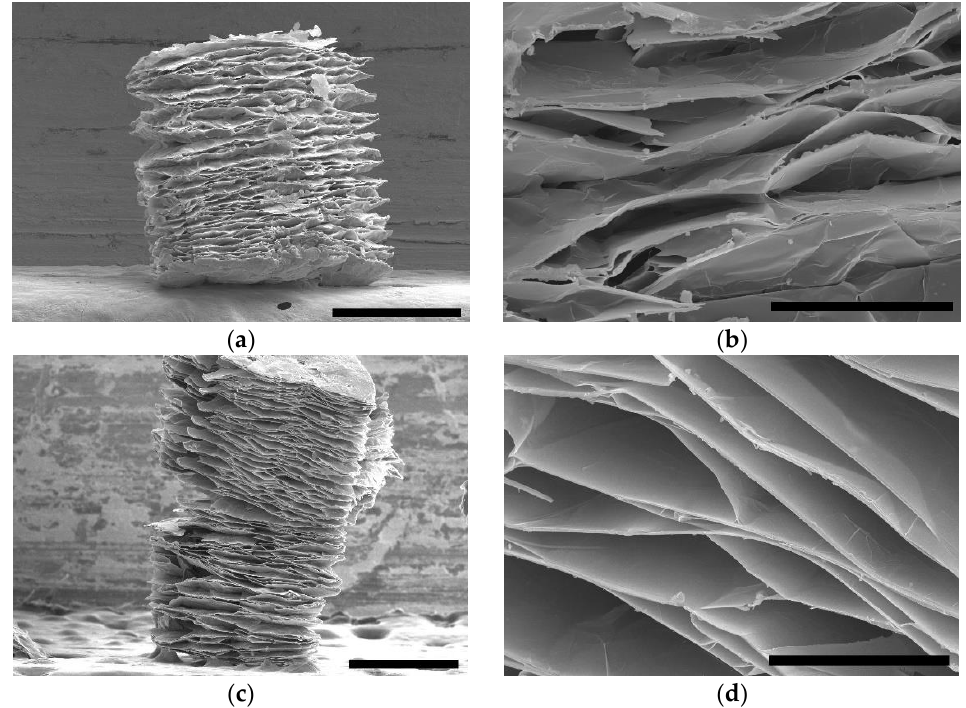
Figure 1. SEM images of ( a , b ) eVMT and ( c , d ) eVMT@PDMS samples. The black scale bars in ( a ) and ( c ) correspond to 500 µ m while the scale bars in ( b ) and ( d ) are 50 µ